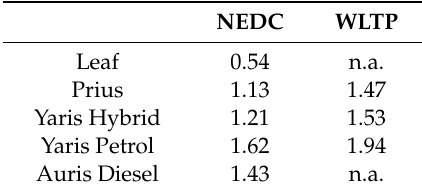
Table 4. Energy consumption in NEDC and WLTP homologation tests (MJ / km).